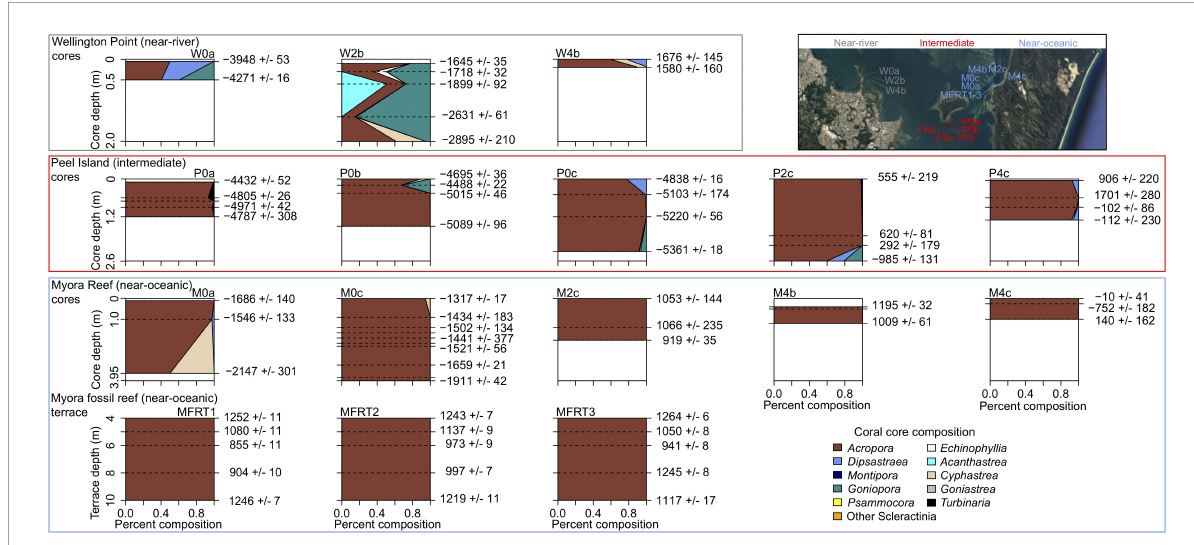
FIGURE4 Percent contribution of coral genera from the fossil assemblages per reef sediment core and the submerged fossil reef terrace of Myora Reef. U-series radiometric ages are reported per core and terrace as Calendar year (AD) ± 2SD error. Note differences in y -axis scales among cores; these were adjusted to accommodate the longest core from each site. Fossil coral assemblages are plotted per interval accretion rate as per Supplementary Table 4 .